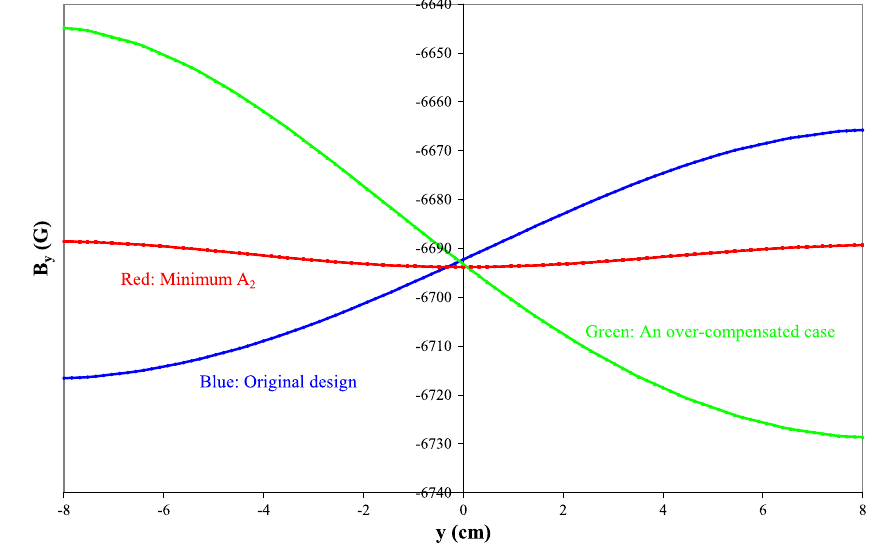
FIG. 13. (Color) B y vs y at x ¼ 0 for y ¼ (cid:1) 8 to þ 8 cm in three different shim Fourier analysis of the data on the semicircle yields a skew quad term of (cid:1) 0 : 002 G , a negligible amount. The green shim geometry also has a trapezoidal cross section with its bottom width of 5.842 cm, height of 2.54 cm, and still 18 (cid:2) on the two side edges. It would produce a field distribution along the y axis, as plotted in Fig. 13. The field at the bottom of the pole tip ( y ¼ (cid:1) 8 cm ) is lower than that on the top ( y ¼ 8 cm ), while it is the opposite in the original design. The maximum difference in B y is 83.7 G. The same Fourier decomposition of the field data on the semicircle yields a skew quad term of þ 61 : 97 G . Note that the sign changes from the original case. This is the consequence of overcompensation by the shim. The other higher harmonics are listed in Table III.